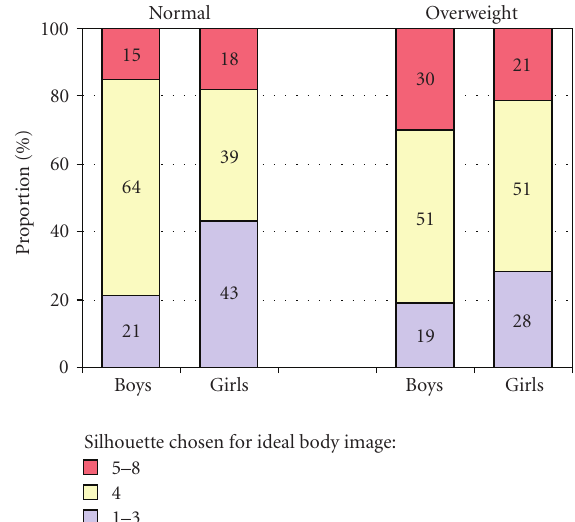
Figure 3: Ideal own body image based on Stunkard’s silhouettes according to sex and actual weight status.